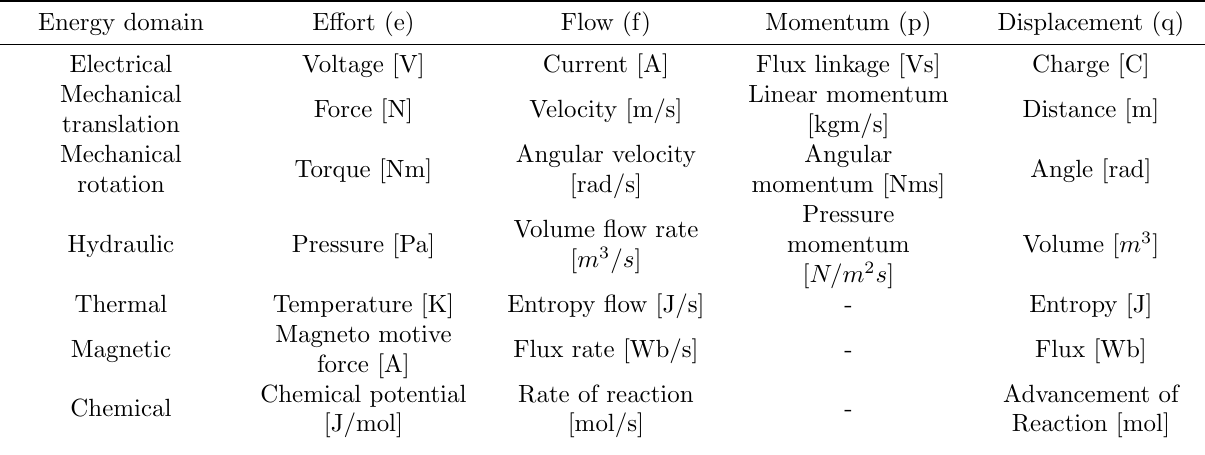
Table 1: Identification of variables Pedersen and Engja